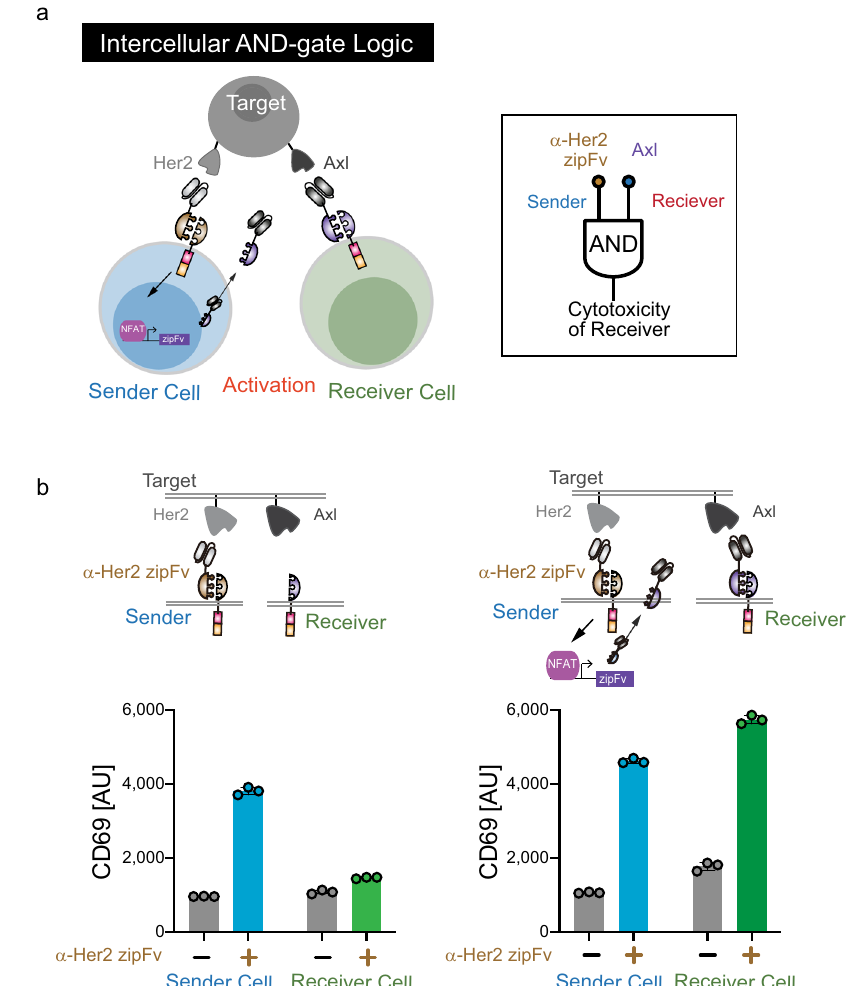
Fig. 7 The intercellular AND gate using zipFv secretion system. a Diagram of intercellular AND gate logic. CD4 + Sender cells express SYN6 CAR and secrete α -Axl-SYN2 zipFv when activated by α -Her2 zipFv. CD4 + receiver cells get activated by α -Axl-SYN2 zipFv secreted by sender cells. b . (Left) Addition of α -Her2 zipFv will activate sender cells that contain zipFv secretion module and secrete α -Axl-SYN2 zipFv, which will activate receiver cells as measured by CD69 expression level (Right) Activation of sender cells without zipFv secretion module does not lead to activation of receiver cells ( n = 3, data are represented as the mean +